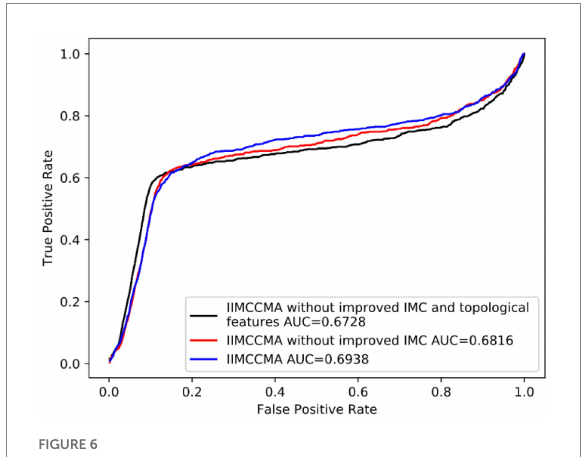
FIGURE 4 Performance comparison between IIMCCMA and other models on dataset 2 in term of AUROC.